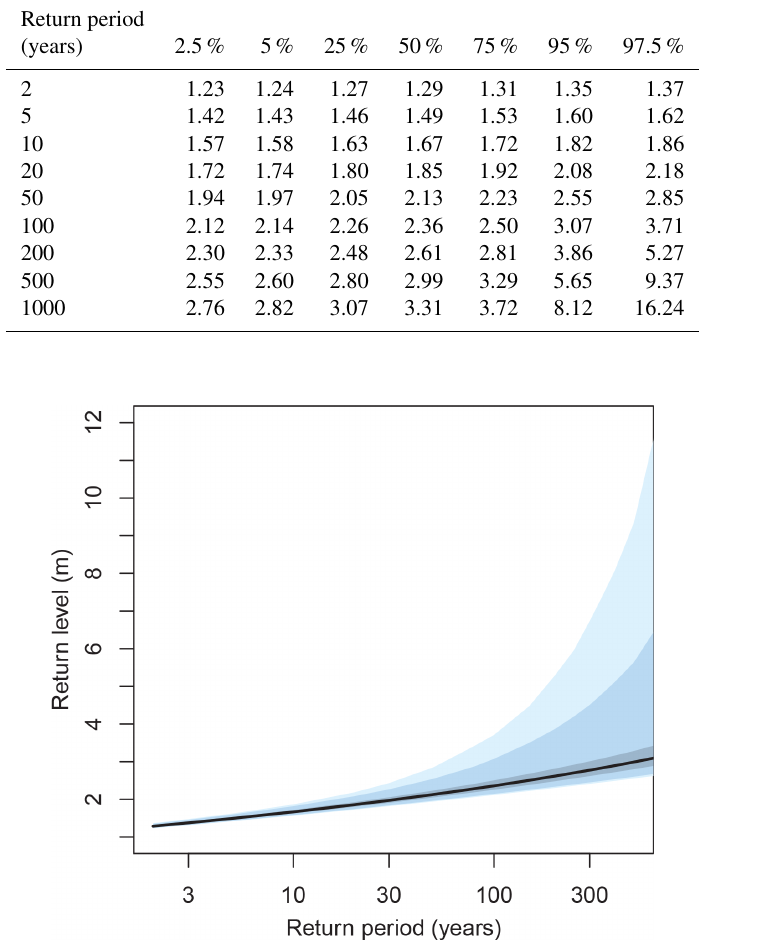
Table A2. Quantiles of the estimated storm surge return levels (meters) for Norfolk (Sewells Point) in 2065 using the full nonstationary multi-covariate BMA model.